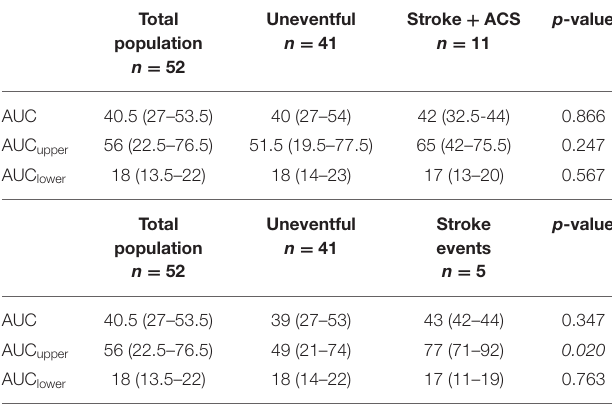
TABLE 2 | Area under the curve (AUC) in the whole blood, and AUC in the upper and lower samples after 1-h gravity sedimentation in the total population and comparison between uneventful vs. stroke + ACS as well as uneventful vs. recurrent stroke subgroups.